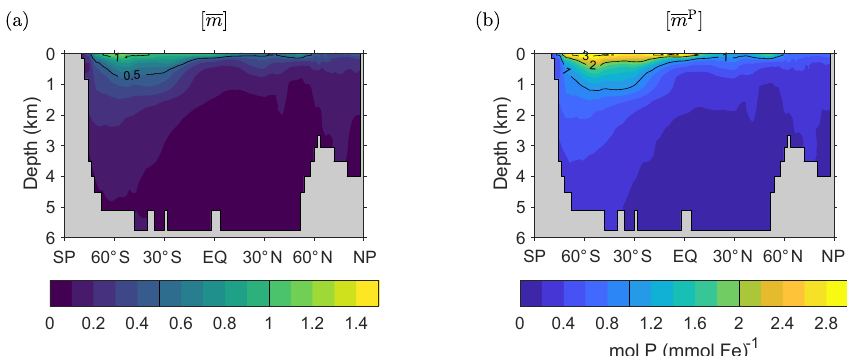
Figure 10. Three-dimensional intrinsic fertilization efficiency metrics for our typical state, zonally averaged across the global oceans. (a) The mean number of iron molecules, m( r ) , that will be regenerated per iron molecule at r during that molecule’s lifetime. (b) The corresponding mean number of phosphorus molecules, m P ( r ) , that will be